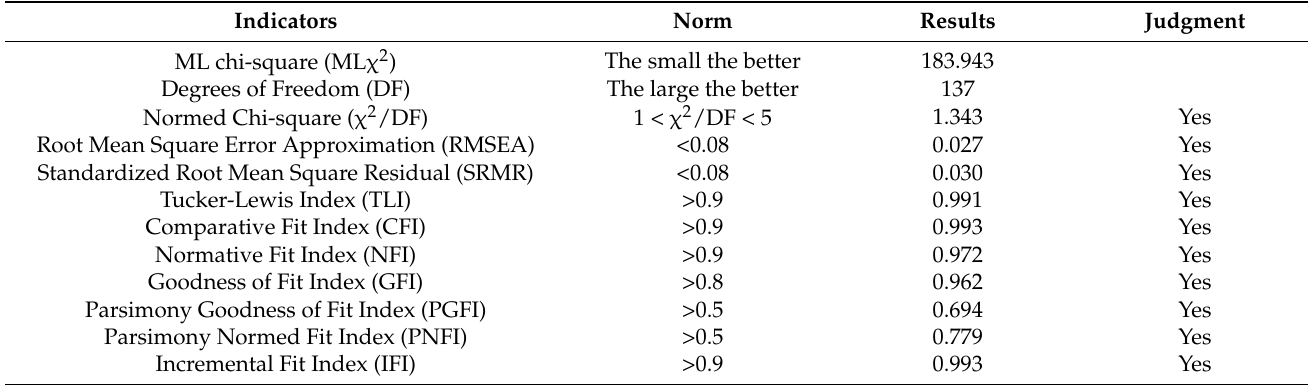
Table 6. Evaluation